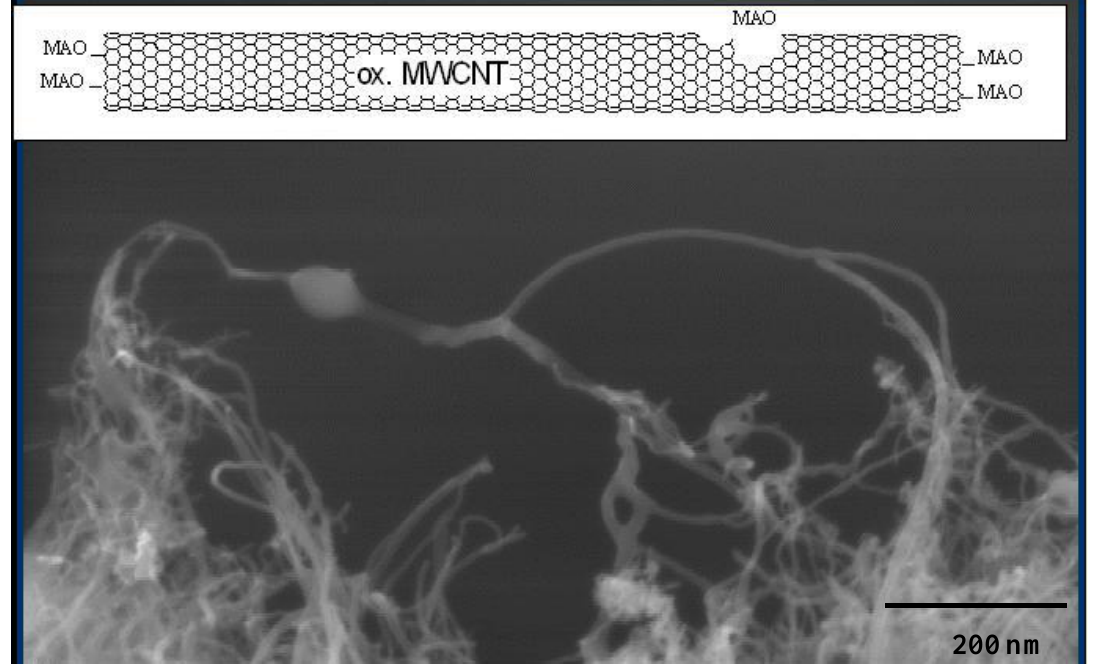
Figure 8. Transmission electron microscopy (TEM) micrograph of oxidized MWCNT